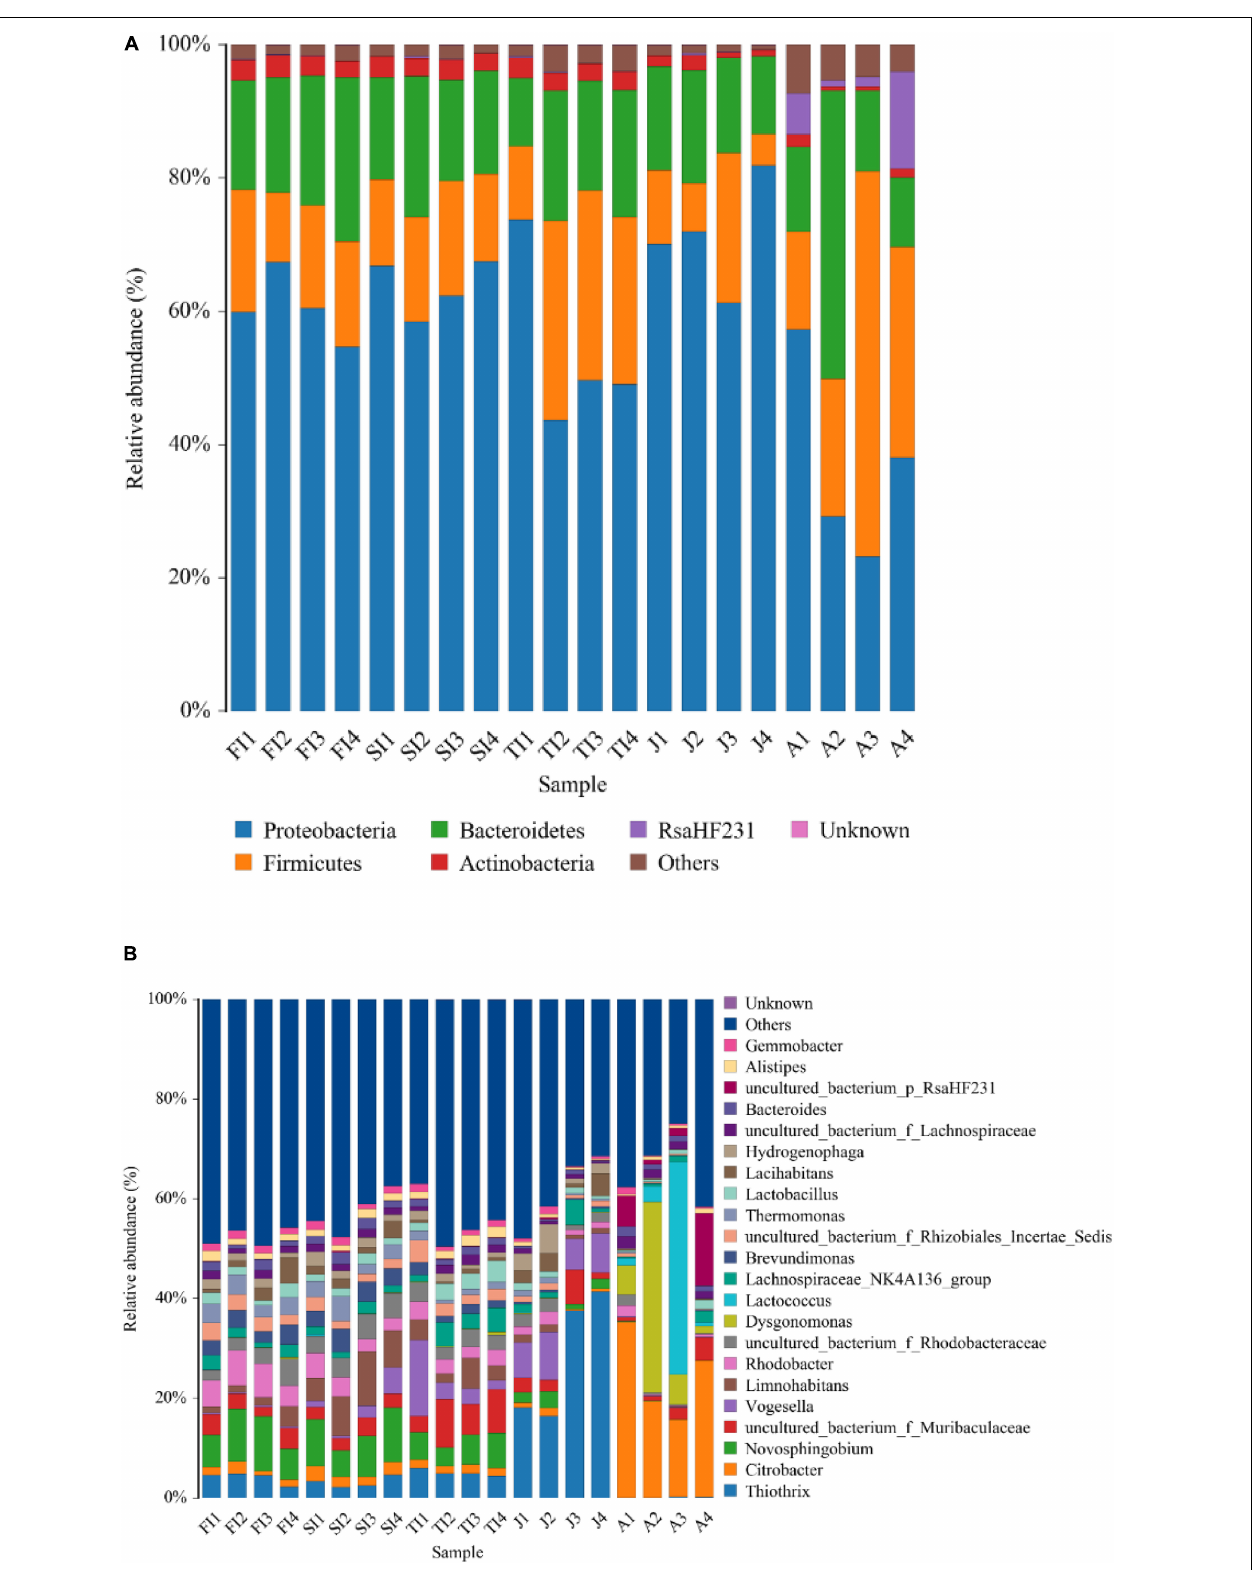
FIGURE 3 | Community bar plot analysis showing the relative abundance of gut bacterial community among the samples by Mothur at the phylum (A) level and genus (B) level. Less than 1% abundance of the phyla/genera was merged into “others.”